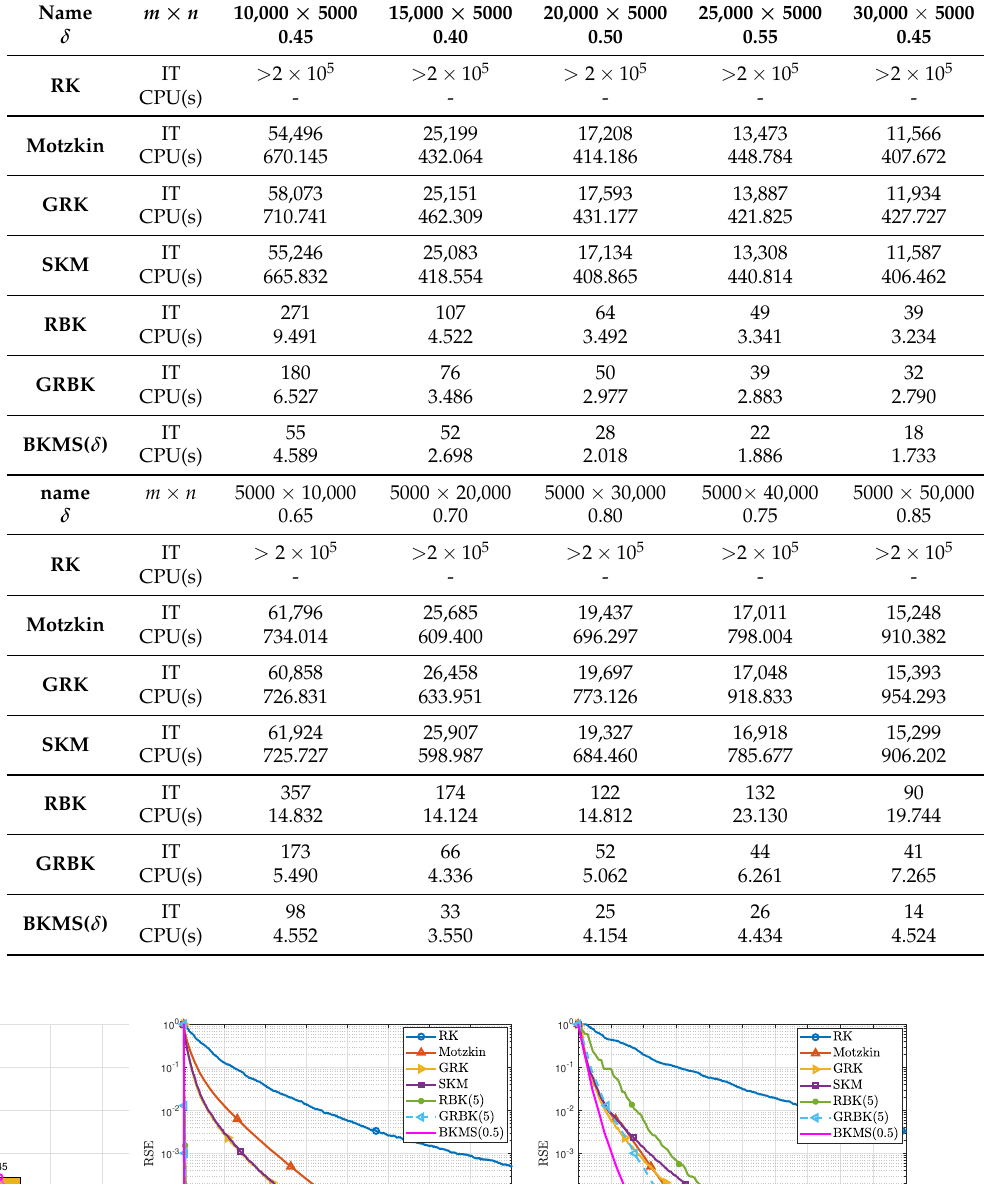
Table 1. IT and CPU of all methods for the m -by- n consistent linear system.